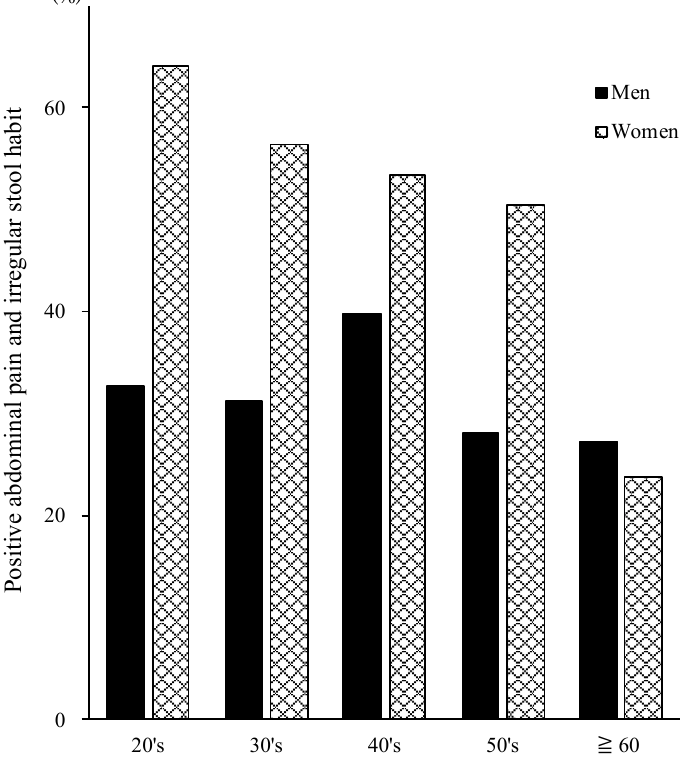
Figure 1. A positive LGIP was more prevalent in the younger generation in women, whereas there were no di ff erences in terms of generations in men. LGIP: lower gastrointestinal